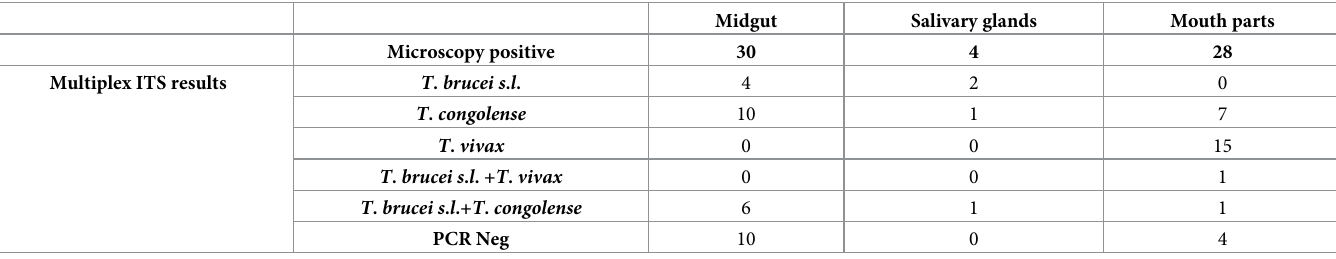
Table 5. Species identification by multiplex ITS primers of microscopy positive tsetse